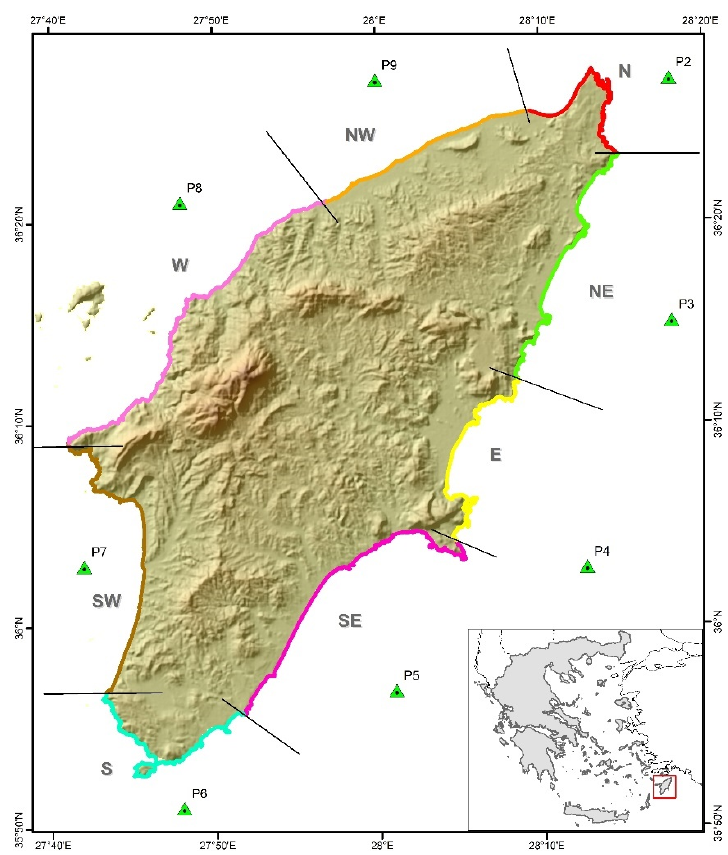
Figure 1. Rhodes Island, Greece, and the locations of data points and geographical parts of the island used for the analysis of storm events.